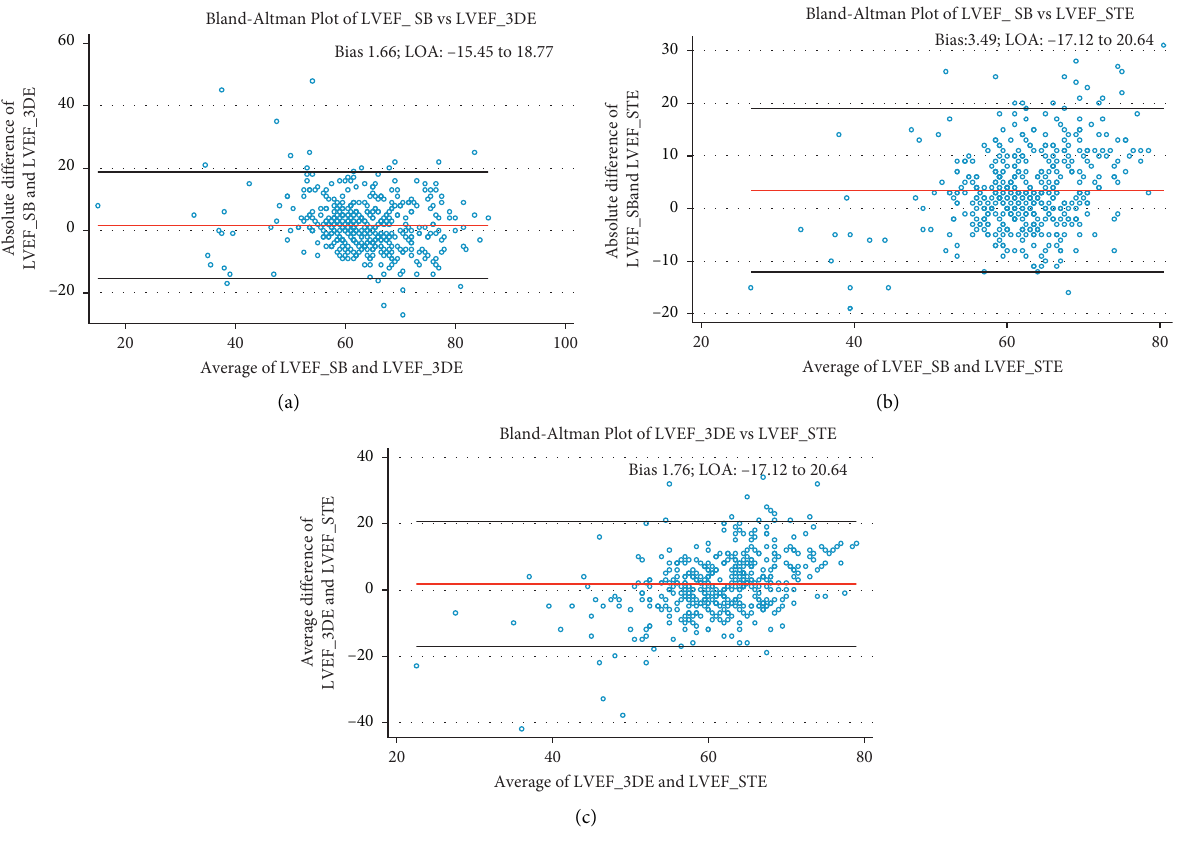
Figure 4: Bland–Altman plots for the comparisons between (a) LVEF_SB and LVEF_3DE, (b) LVEF_SB and LVEF_STE, and (c) LVEF_3DE and LVEF_STE. Bias: 1.66% (95% CI 0.86–2.47); bias: 3.49% (95% CI 2.77–4.20); and bias: 1.76% (95% CI 0.86–2.65),